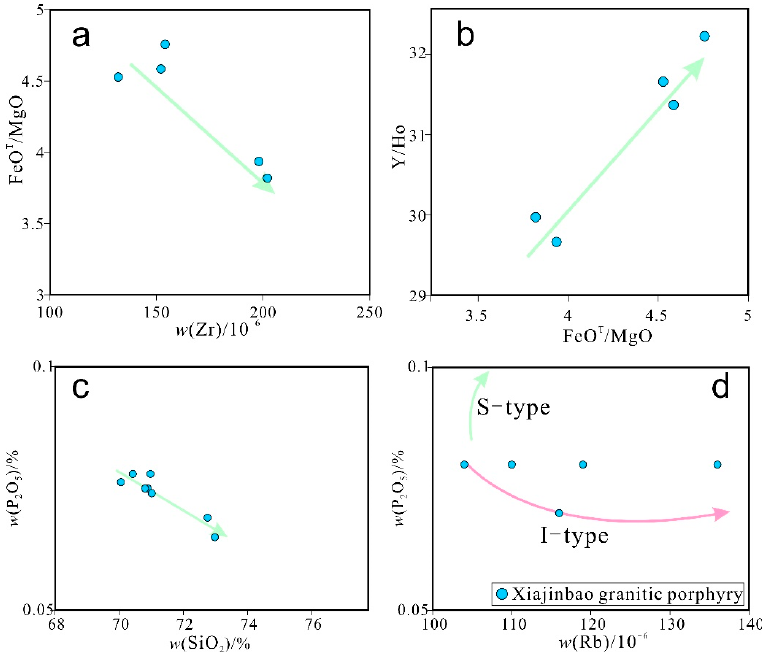
Figure 15. FeO T /MgO vs. SiO 2 ( a ), Y/Ho vs. FeO T /MgO ( b ), P 2 O 5 vs. SiO 2 ( c ), and Rb vs. P 2 O 5 ( d ) diagrams for the Xiajinbao granite porphyry.